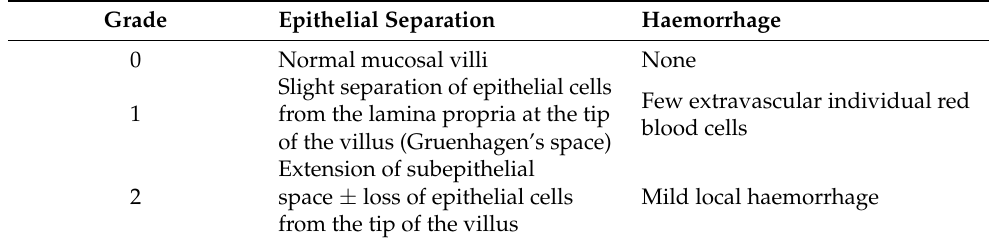
Table 2. Modified Chiu score * for histomorphology of intestinal